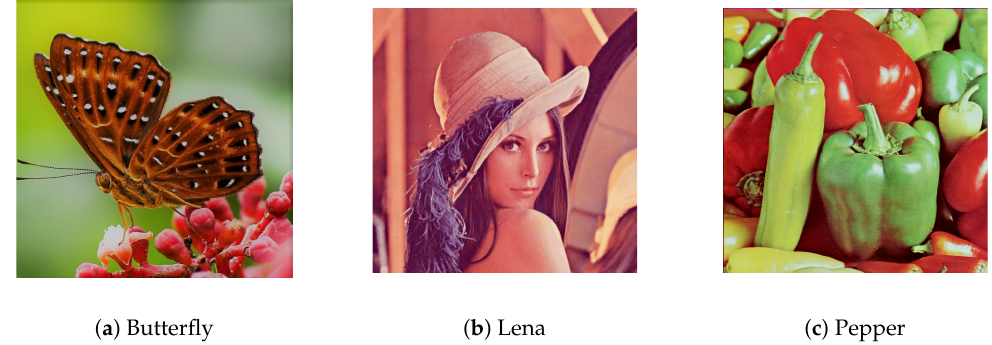
Figure 1. Original test images. ( a ) Butterfly, ( b ) Lena, and ( c ) Pepper.